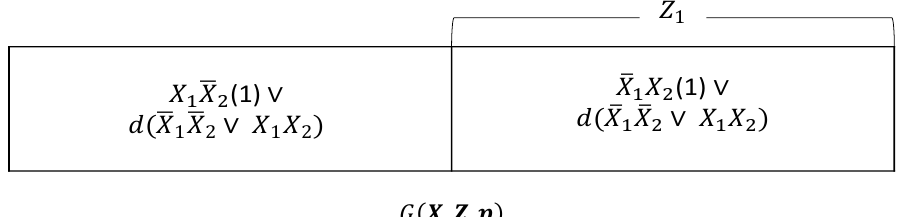
Fig. 13. The auxiliary function for Example